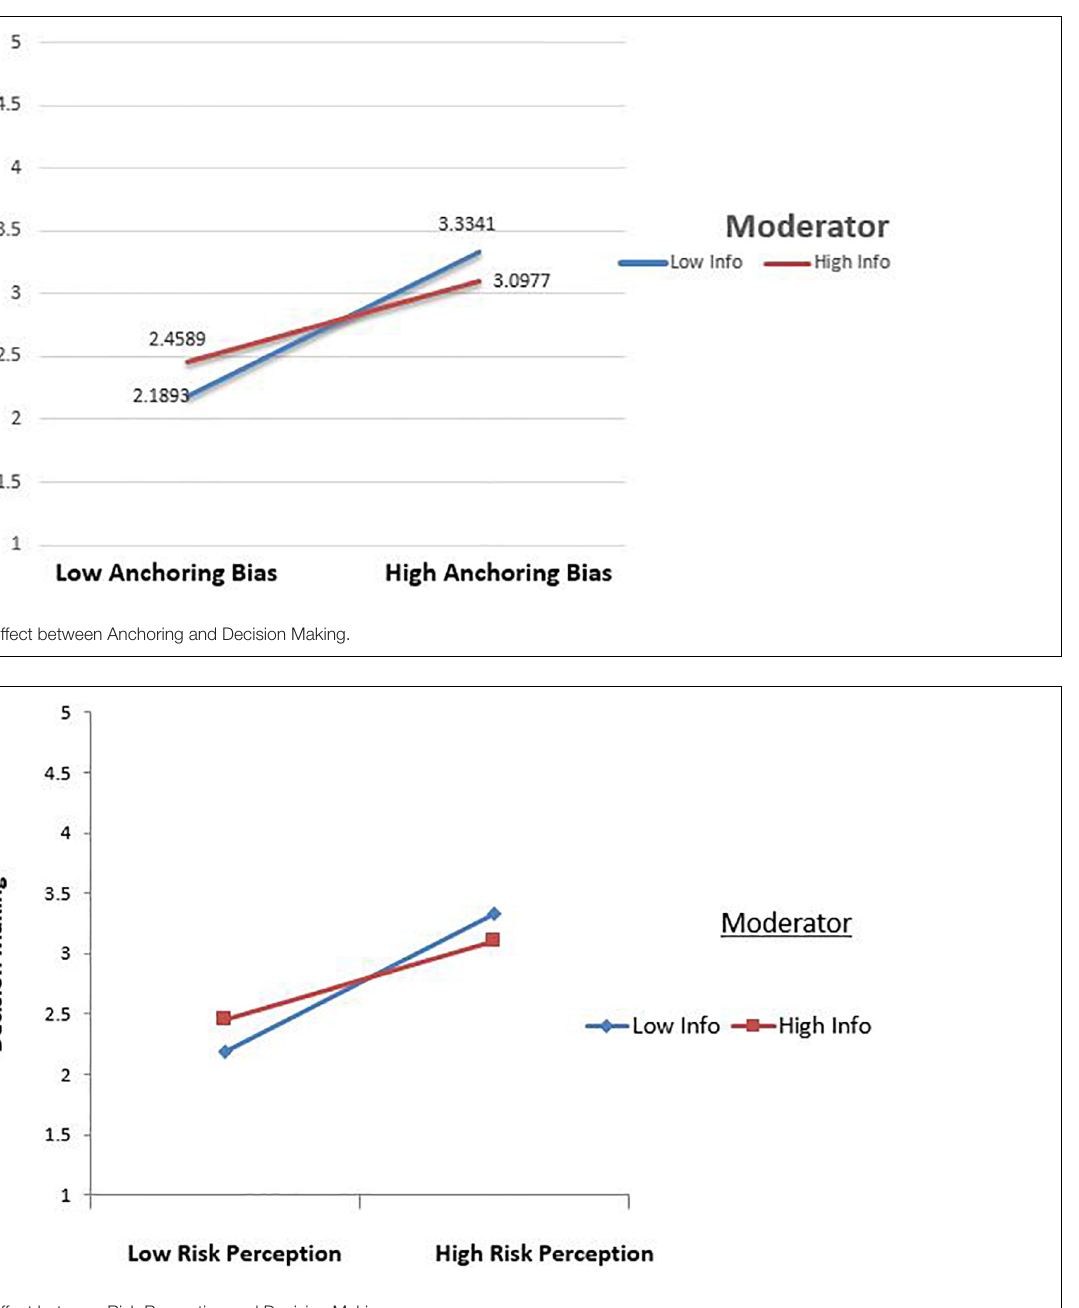
FIGURE 3 | Interaction effect between Risk Perception and Decision